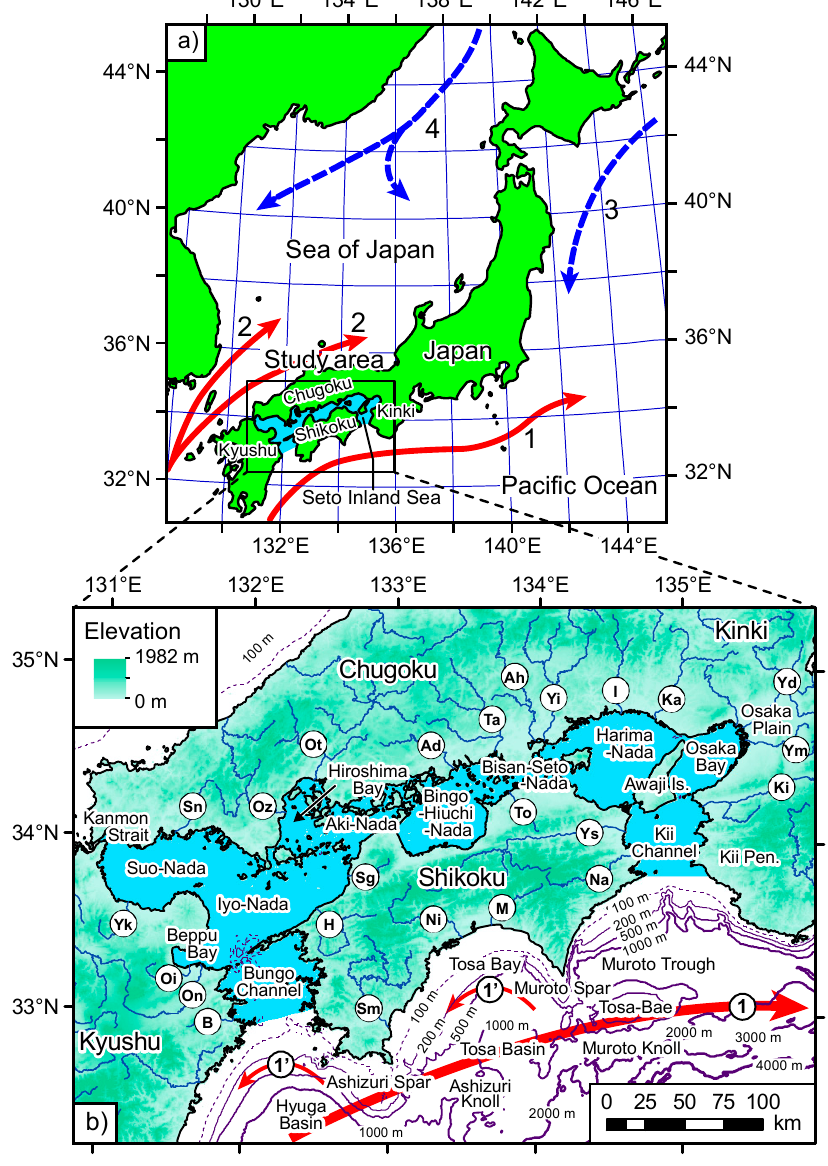
Figure 1. ( a ) Generalized location map of the study area; ( b ) Geographic map of the study area. Solid blue lines in terrestrial areas show major rivers. The abbreviations indicate the river names, as listed in Table A1. The blue colored area is the Seto Inland Sea. 1: Kuroshio Current; 1’: Kuroshio Counter ‐ Current; 2: Tsushima ‐ Current; 3: Oyashio ‐ Current; 4: Liman ‐ Current. Bathymetric depth contours are delineated using a dataset provided by the Japan Oceanographic Data Center.